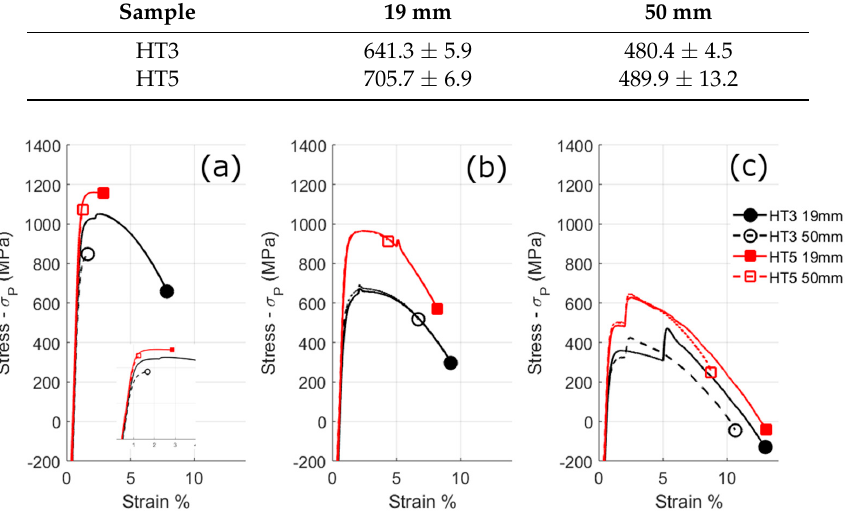
Table 4. The Vickers hardness in HV-20 of the different conditions.